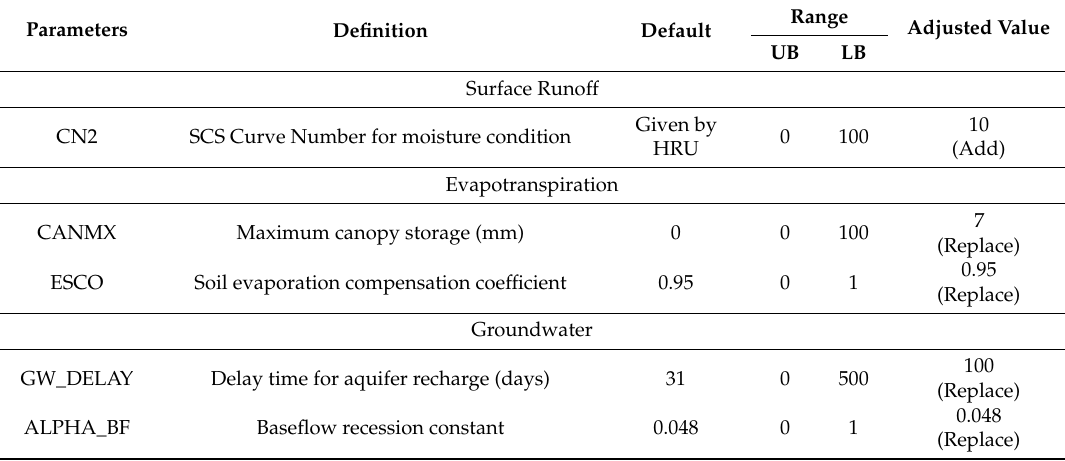
Table 2. The Soil and Water Assessment Tool (SWAT) calibrated parameters for dam inflow and